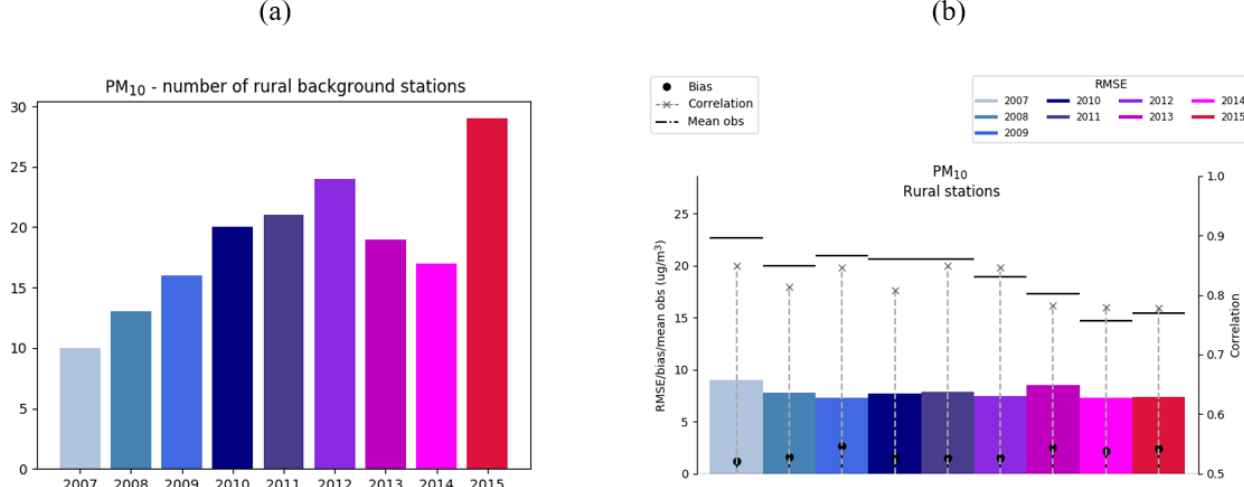
Figure 1. PM 10 : statistical indicators calculated using cross-validation technique on daily mean PM 10 values measured and estimated over rural background stations for the years 2007 to 2015. (a) Number of rural stations for each year. (b) Mean bias (black circles), RMSE (colored rectangles), correlation (grey crosses and the associated dashed lines) and mean observation (horizontal lines).